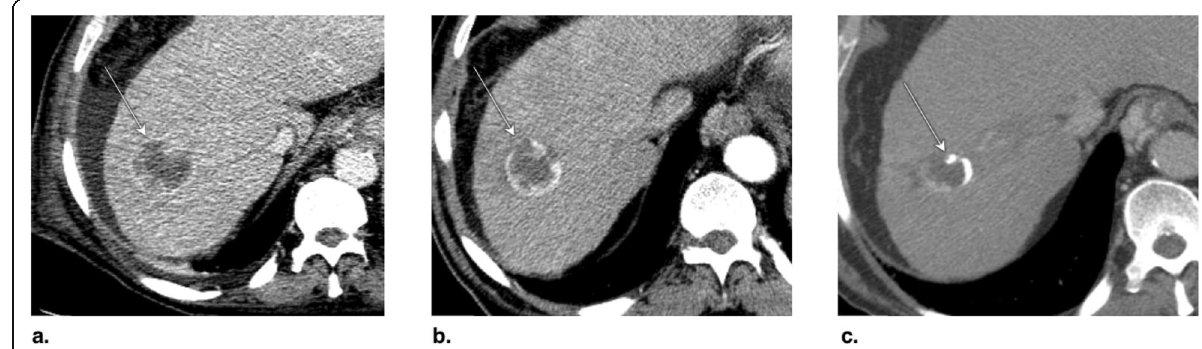
Fig. 26 Axial CT obtained ( a ) pretreatment: image in portal venous phase shows enhancing “ capsule ” and washout of a LR-5 observation in segment VII. b 4 months post drug-eluting beads TACE (DEB-TACE): image in late arterial phase shows thicker peripheral arterial phase hyperenhancement (arrow). The treated observation is categorized LR-TR viable. The lesion was subsequently treated with transarterial chemoembolization (TACE). c Axial-unenhanced CT post TACE: image shows the expected ethiodized oil retention